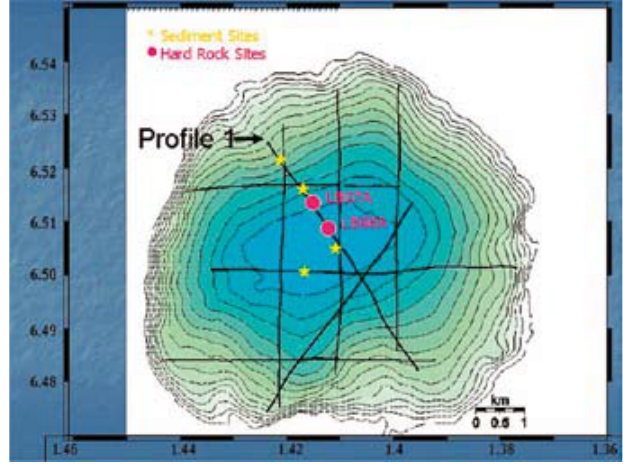
Figure 4. Location map with ICDP boreholes and seismic profile shown in Fig. 6.